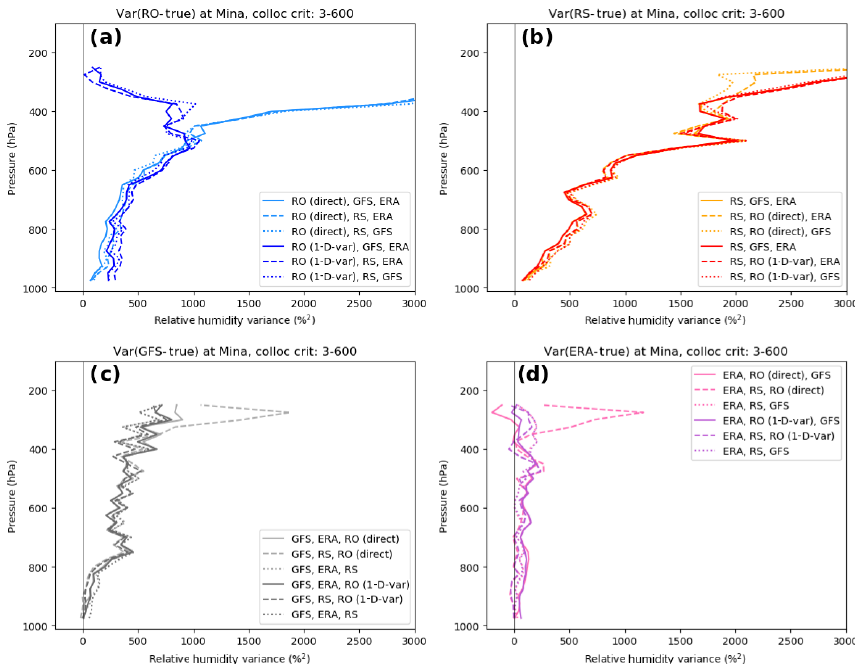
Figure 7. Estimated error variances (percent squared) of relative humidity at Mina: (a) RO, (b) RS, (c) GFS, and (d) ERA.